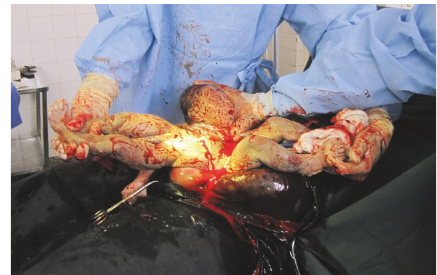
Figure 2: Surgery site during cesarean section.